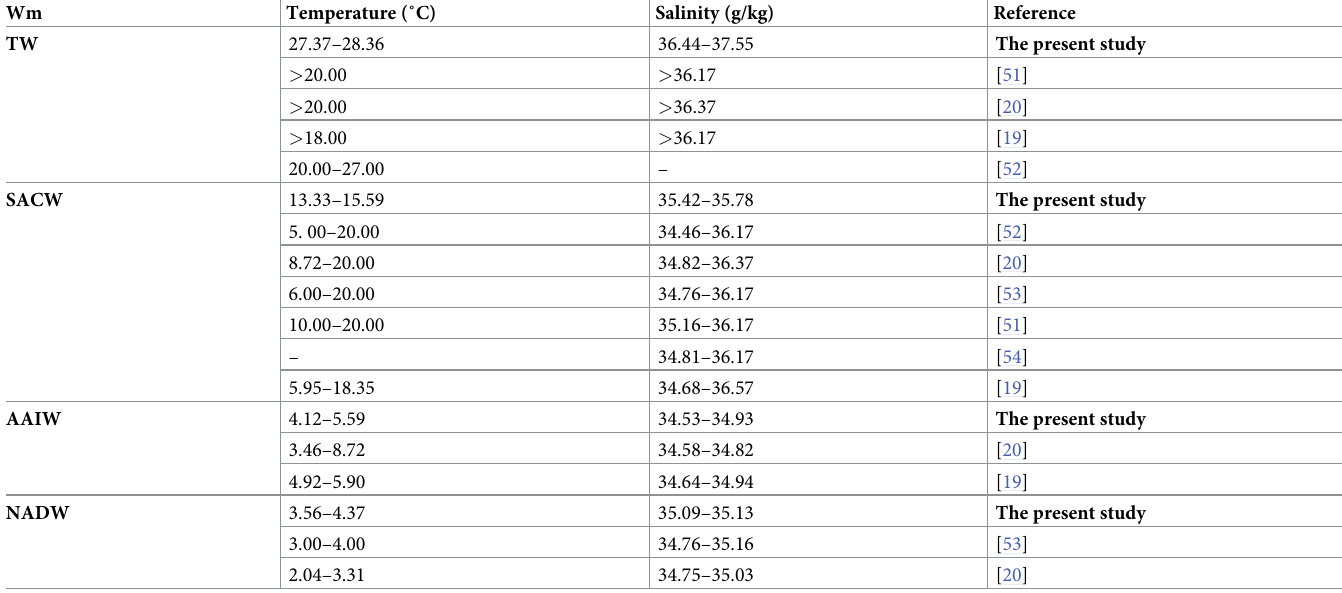
Table 4. Temperature (˚C) and salinity (g/kg) for each water mass (Wm). Comparison with previously published results.